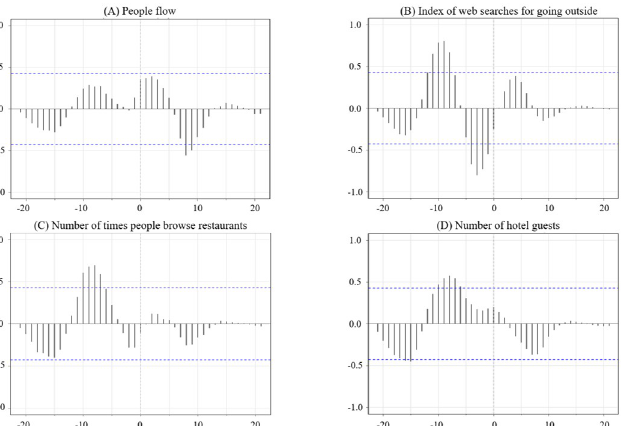
Fig 3. Cross-correlation of new PCR positive cases with A) people flow, B) the index of web searches for going outside, C) the number of times people browse restaurants, and D) the number of hotel guests in the second wave. The y-axis indicates the correlation coefficient and the x-axis indicates the lag. Dashed blue lines indicate 95% confidence intervals for a null model of no association.